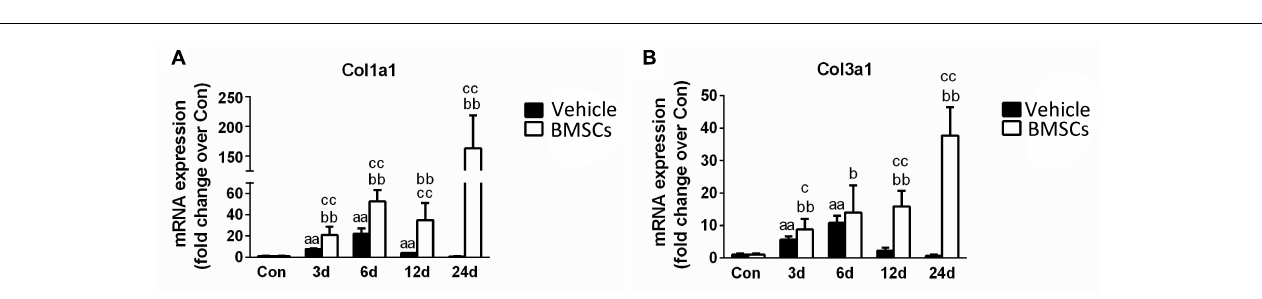
FIGURE 4 | Representative images of fibrosis formation in injured GMs. (A) Control muscle; (B) Vehicle treated group (24 days post-injury); (C) BMSCs treated group (24 days post-injury); (D) Quantification of the scar tissue area in injured GMs. Scale bars = 50 µ m. Data are means ± S.D., n = 6. ∗∗ Significant difference from S24, ∗∗ P < 0.01. The BMSCs treated mice showed more fibrosis than the vehicle treated mice at 24 days post-injury.